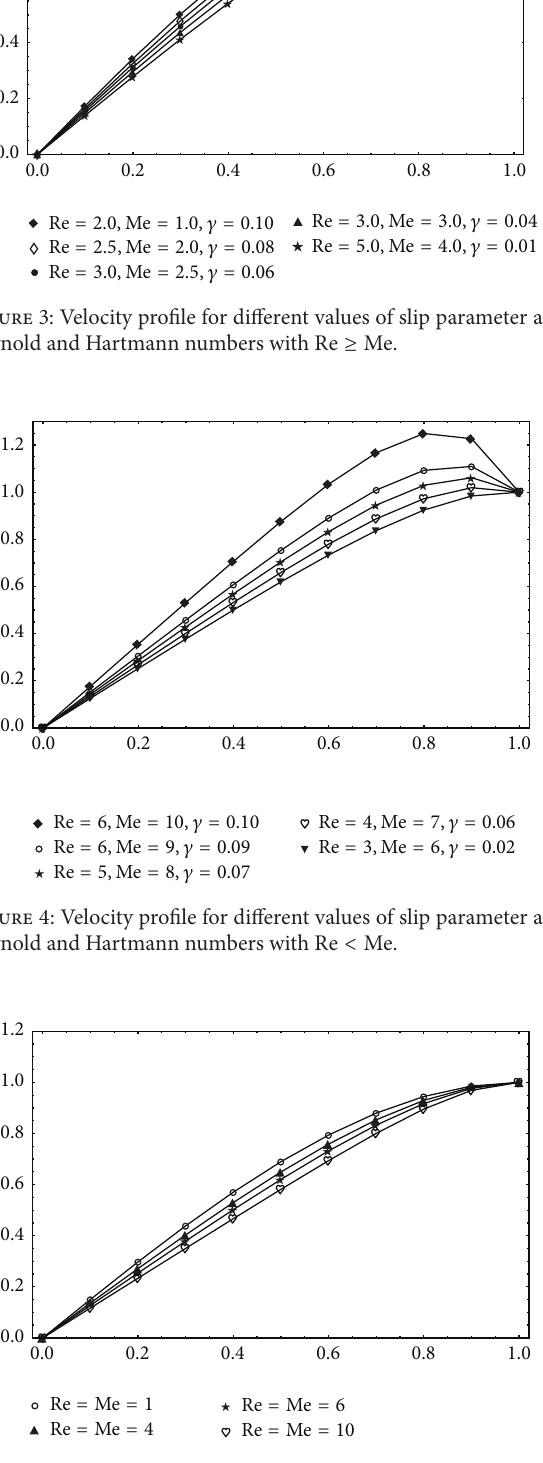
Figure 5: Velocity profile for different values of Reynold and Hartmann numbers with Re = Me and 𝛾 = 0